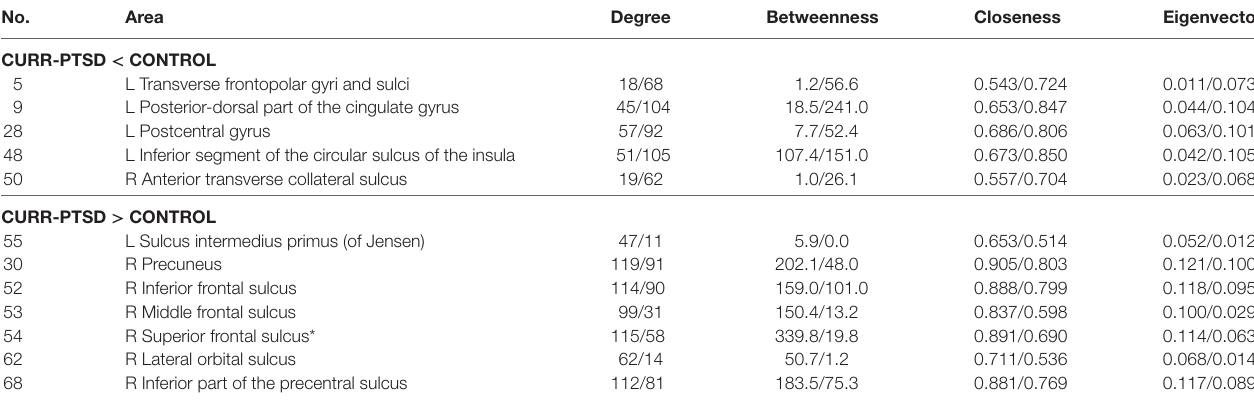
TaBle 4 | Centrality between-group comparisons: CURR-PTSD (current PTSD group) versus CONTROL (control group with trauma exposure).